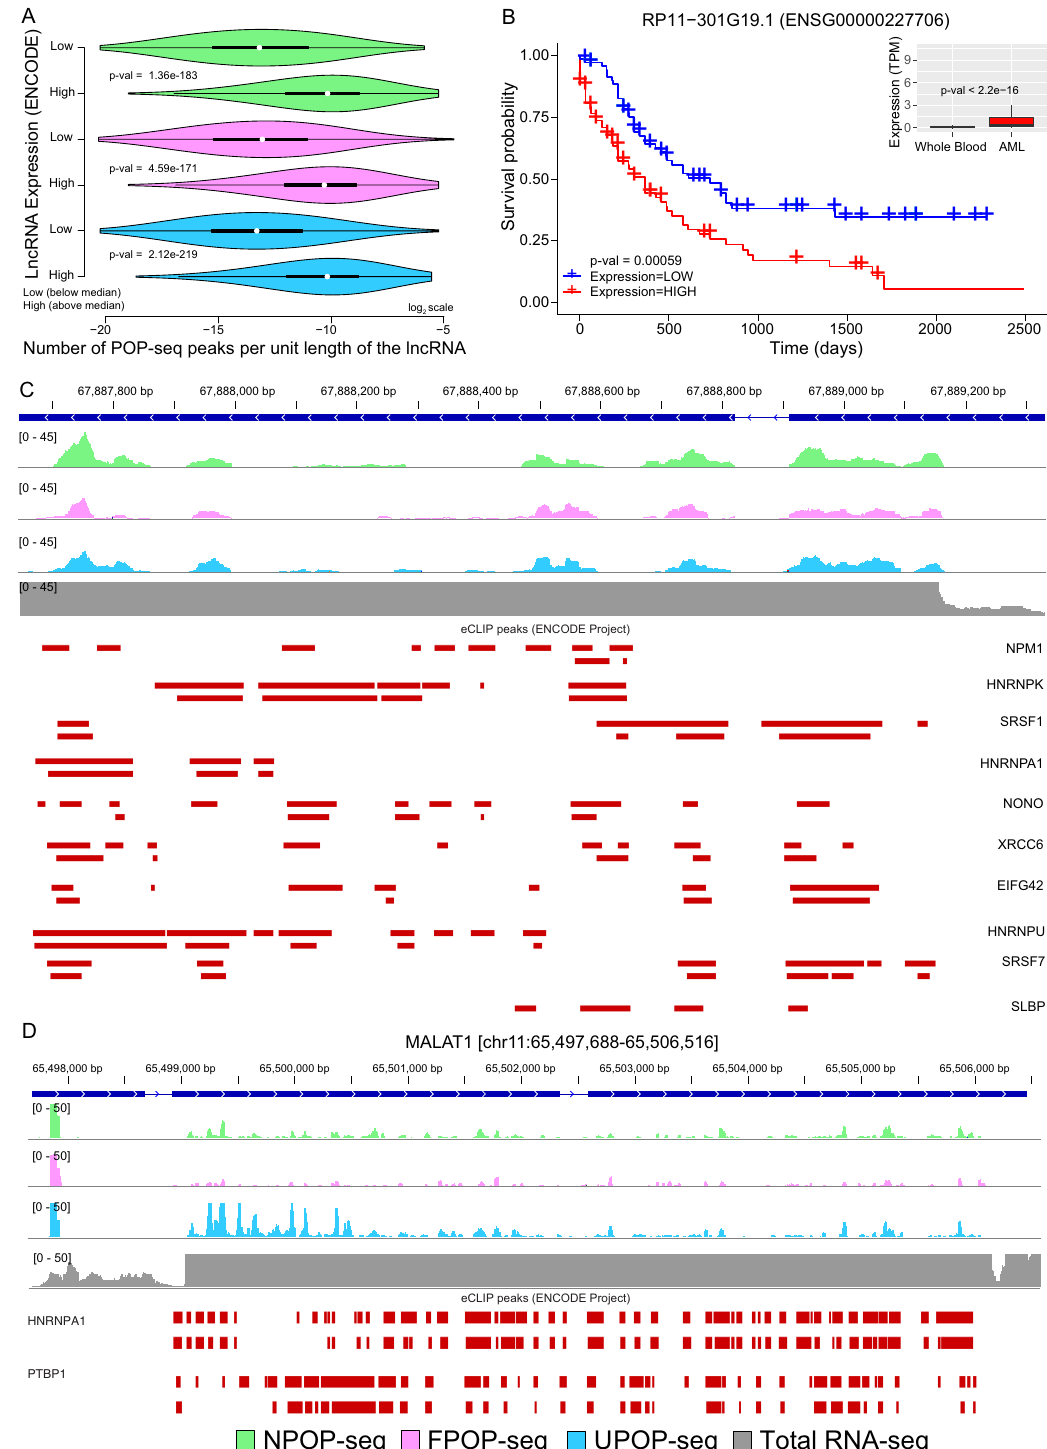
Figure 7. Comparative analysis of POP-seq peaks with lncRNA expression. ( A ) Violin plot showing the number of POP-seq peaks (normalized per unit length of the lncRNA) binned in low and high expression group of lncRNAs in K562 cells. The difference in normalized peak counts between the two groups was statistically tested using Wilcoxon test. ( B ) Kaplan–Meier plot showing the association of lncRNA RP11 − 301G19.1 expression with the survival of AML patients (in days). An inset showing the expression of RP11 − 301G19.1 in whole blood (GTEx) cohort and AML patients (from TCGA) where the difference between the two groups was statistically tested using Wilcoxon test. ( C ) Genomic tracks showing the distribution of POP-seq variant peaks in RP11 − 301G19.1 along with the eCLIP profile of highly expressed RBPs in K562 cells. ( D ) Genomic tracks showing the distribution of POP-seq peaks in MALAT1 along with the eCLIP profile of HNRNPA1 and PTBP1 in K562 cells. Total RNA-seq data (from K562 cells) is included in the track as a background control (Y-axis adjusted to POP-seq coverage